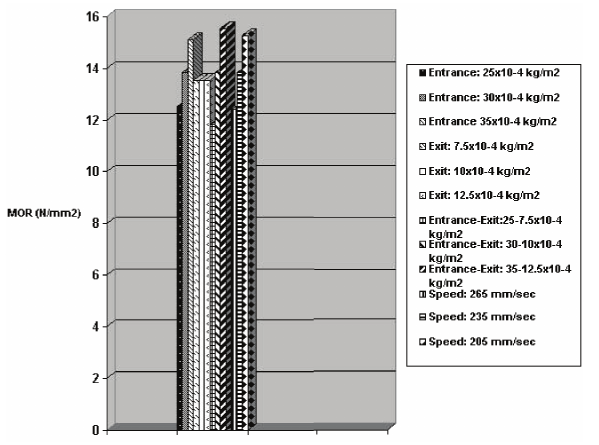
Figure 2. Effects of entrance and exit pressures, and feed- ing speed on the modulus of rupture.